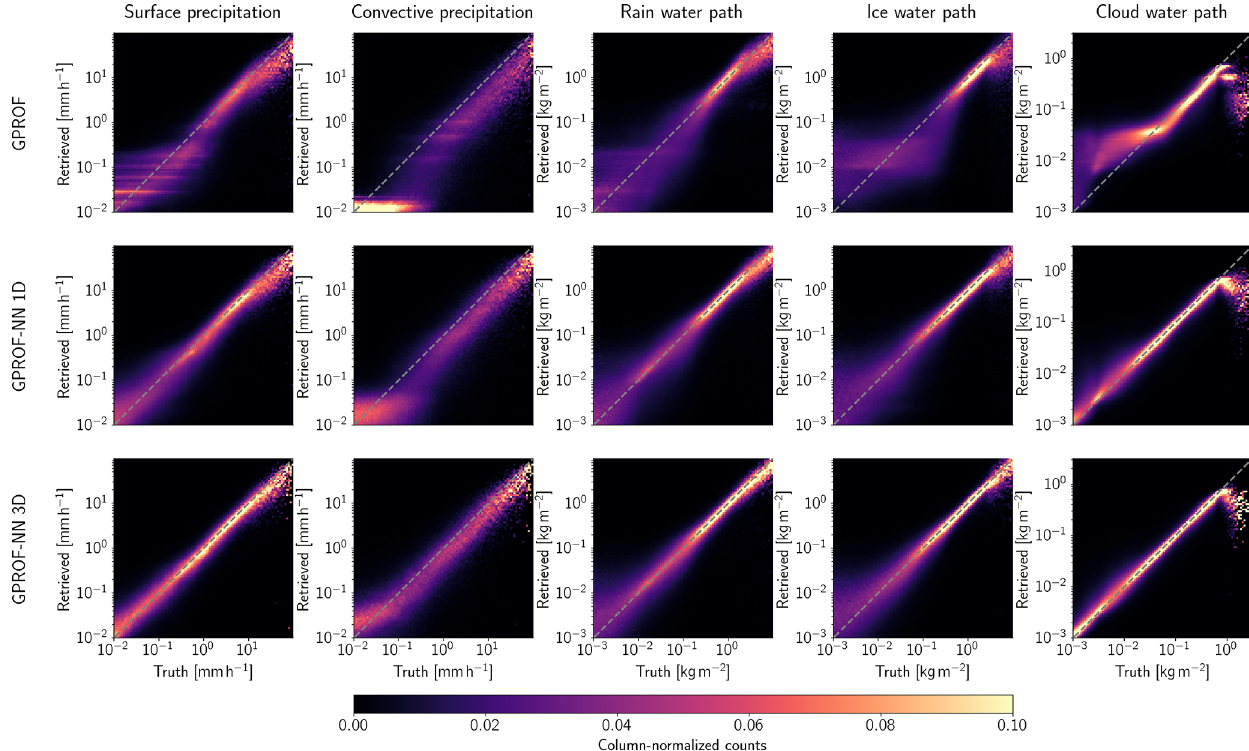
Figure 5. Scatter plots of scalar retrieval targets for the three retrieval algorithms for GMI. Rows display the results for the GPROF, GPROF- NN 1D, and GPROF-NN 3D algorithms, respectively. Columns display the results for different retrieval targets. Frequencies in the plots have been normalized column-wise, i.e., per bin of the reference value. Table 4. Mean error metrics and estimated standard deviation for surface precipitation retrieved from GMI